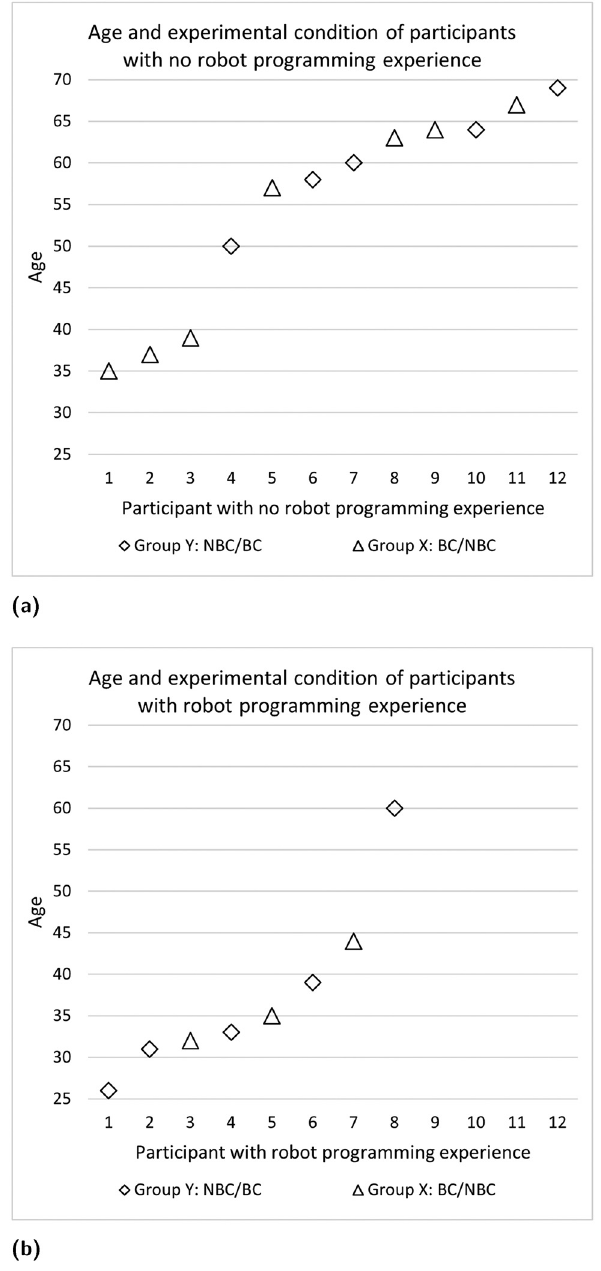
Figure 11: Participants ’ age distribution across di ff erent experi - mental conditions. ( a ) Distribution of participants with no robot programming experience. ( b ) Distribution of participants with robot programming